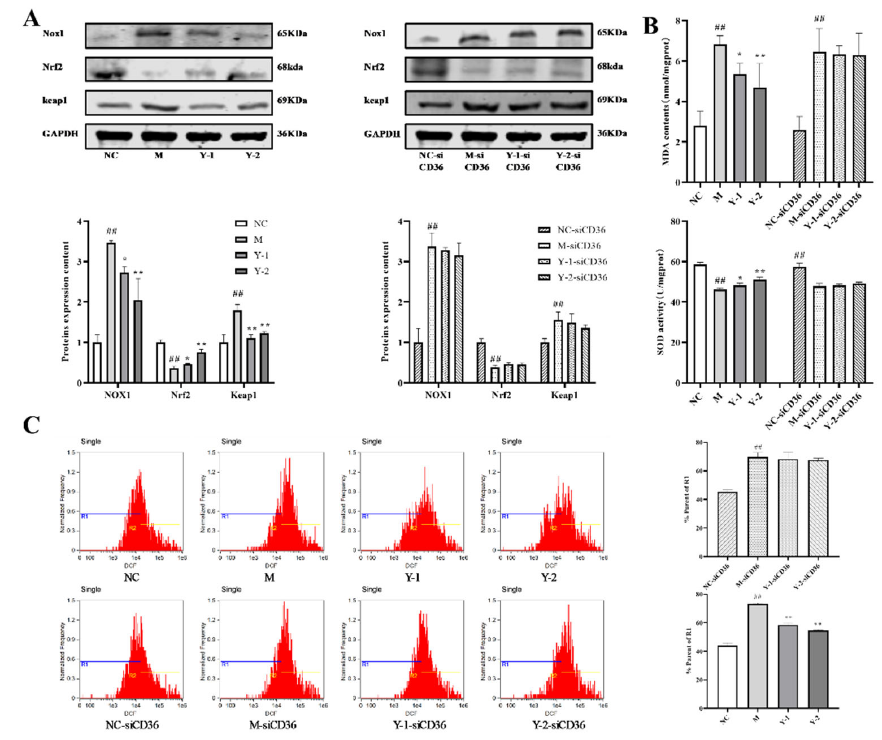
Figure 5. Effects of Y ‐ 1 and Y ‐ 2 on oxidative stress of NRK ‐ 52e cells stimulated by sodium oleate with/without CD36 silences. The expression of NOX1, Nrf2, and Keap1 protein in NRK ‐ 52e cells was quantified by Western blot and normalized ( n = 3) ( A ). The levels of SOD and MDA in NRK ‐ 52e cells were determined by colorimetric method ( n = 6) ( B ). The levels of ROS in NRK ‐ 52e cells were determined by FlowSight multi ‐ dimensional panoramic flow cytometer ( n = 3) ( C ). Compared with NC or NC ‐ sicD36 group, ## p < 0.01; compared with M or M ‐ sicD36 group, * p < 0.05, ** p < 0.01.